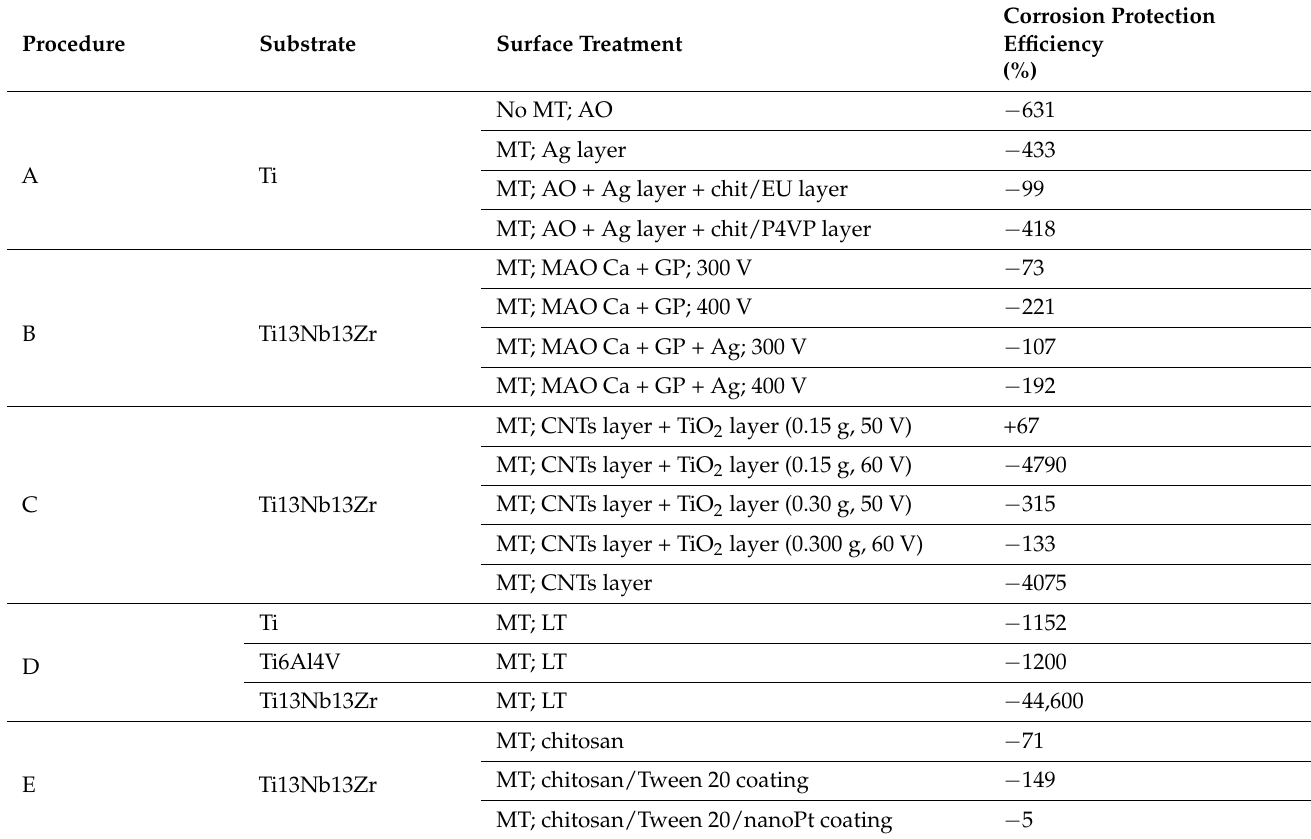
Table 5. Corrosion protection efficiency calculated for different surface